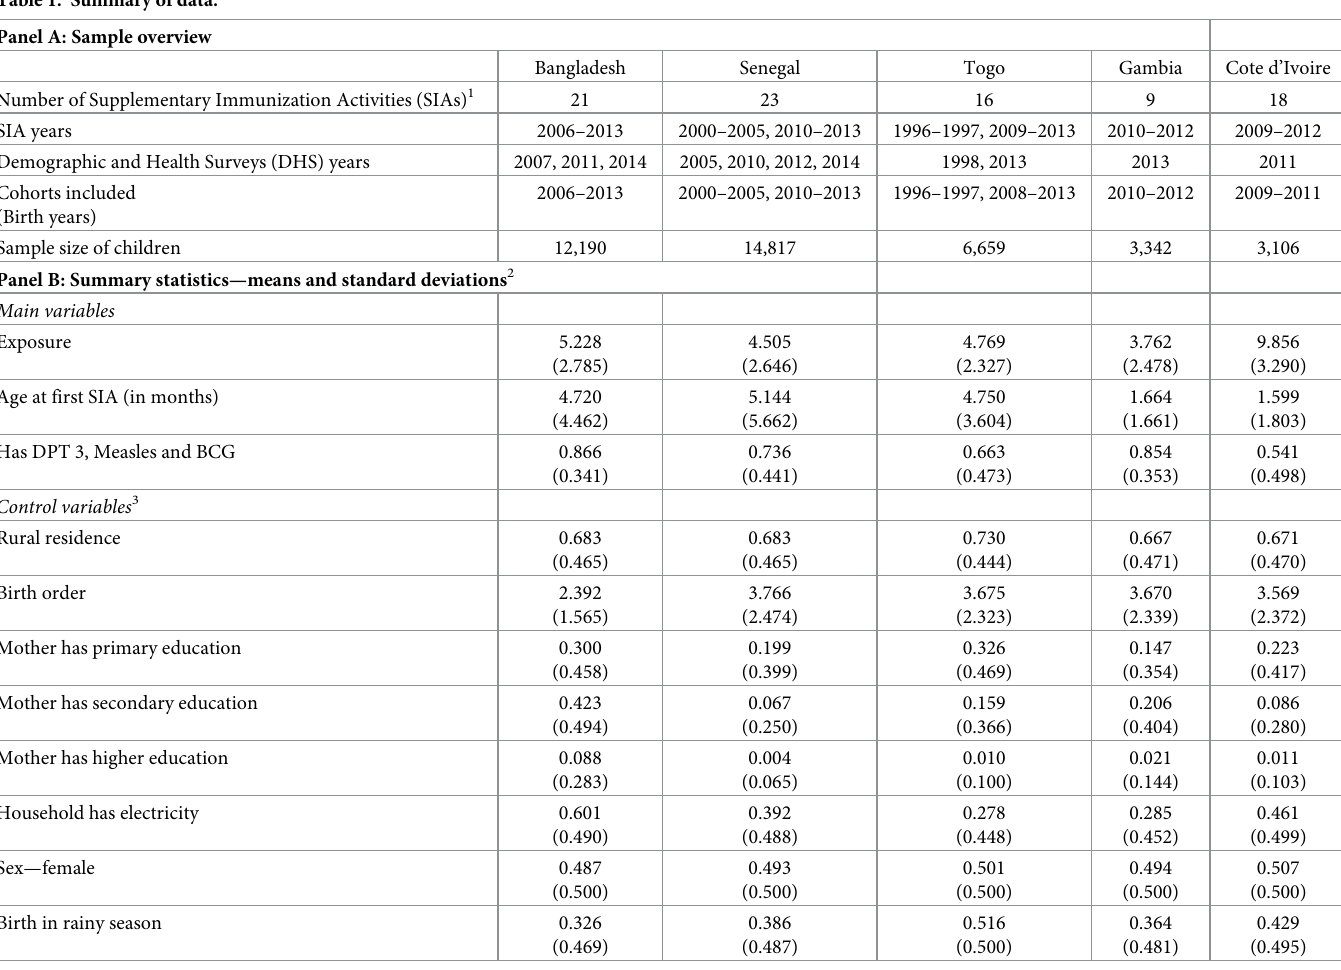
Table 1. Summary of